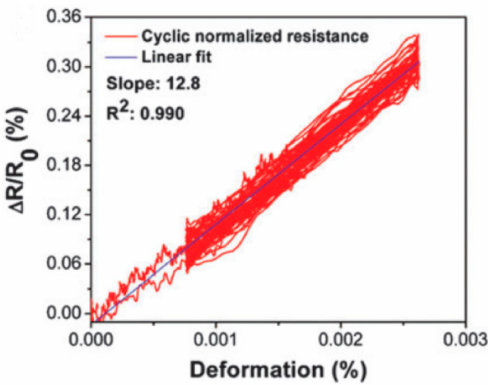
Figure 16. Resistance–deformation relationship of graphene / epoxy composites. Reproduced with the permission from the authors of [140]. Copyright 2016. The Royal Society of